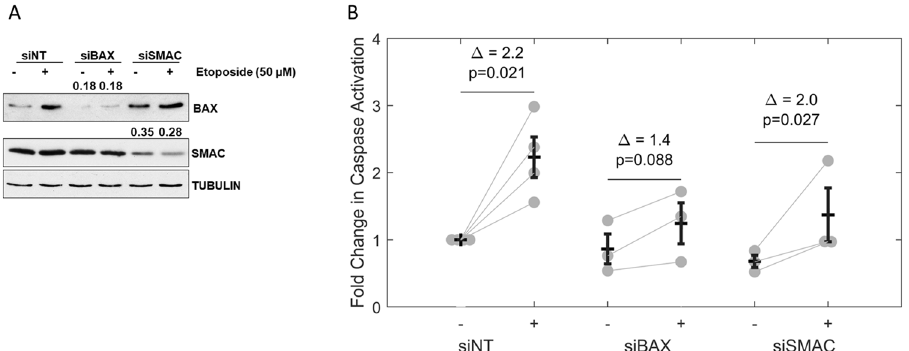
Figure 6. siRNA-mediated downregulation of BAX and SMAC reduces caspase activation upon Etoposide treatment. ( A ) HeLa cells were transfected with either BAX, SMAC or non-target (NT) siRNA and 36 h after transfection the cells were treated with 50 µM Etoposide for 18 h in growing conditions where indicated. Cell lysates were collected, and expression levels of BAX and SMAC proteins were monitored by blotting with specific antibodies. Tubulin α was used as loading control. ( B ) HeLa cells treated as in A were collected from the media or after trypsinization and caspase activation was assessed by FITC-VAD-FMK binding and measured by flow cytometry. The percentage of FITC-VAD-FMK positive cells is represented on the y-axis. Fold change in knockdown is as annotated by Δ. Bars (middle) and error bars (top, bottom) indicate mean + /− standard deviation. In the BAX knockdown, inducing caspase activation with etoposide showed not statistically significant difference compared to DMSO control (p-value = 0.088), whereas in the SMAC knockdown etoposide significantly induced caspase activation (p-value = 0.027) with a fold change similar to the no-knockdown control (1.8 for SMAC knockdown versus 2.0 for siNT control). p-values represent a paired-sample t-test with pairing by experiment (in each experiment the control (−) and knockdown ( +) values were